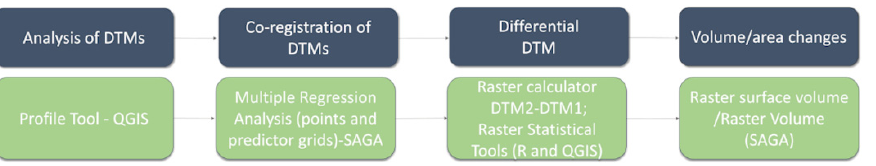
Figure 7. Volume change workflow.